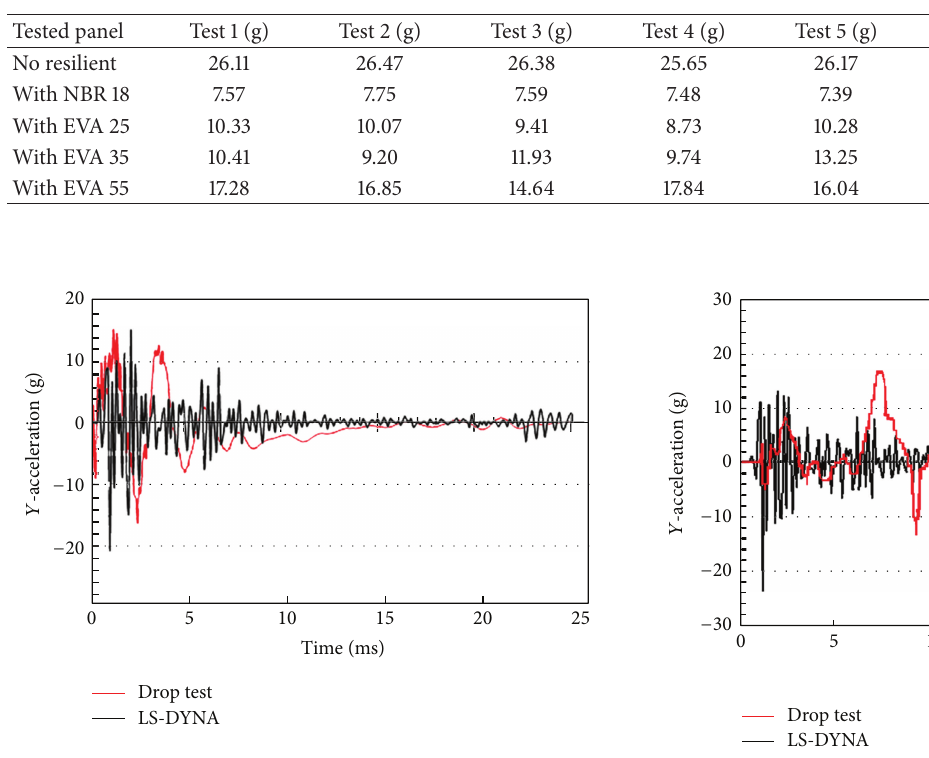
Table 6: Measured and simulated maximum acceleration under resilient materials.